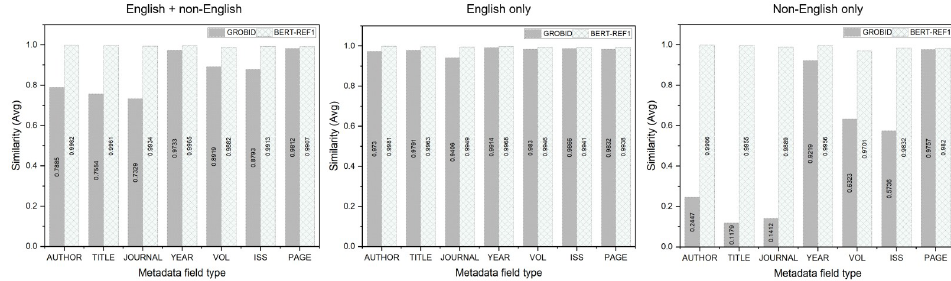
Fig 8. Similarity performance of GROBID and BERT-REF1 for the metadata field types based on Levenshtein distance. The first graph shows the results for all the 12,887 references; the rest represent the results for the 9,539 English and 3,348 non-English